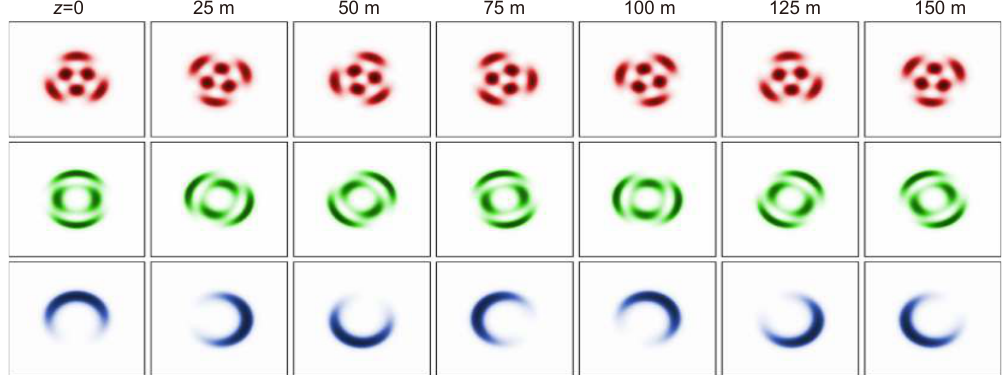
Fig. 18 | Propagation of LP modes superposition in a weakly guiding stepped-index FO (the intensity distribution is taken at different distances z ) for ( p , q )=(1, 2)+(–2, 1) (top row), ( p , q )=(3, 2)+(5, 1) (middle row), ( p , q )=(4, 1)+(5, 1) (bottom row). Figure reproduced from ref. 189 , Pleiades